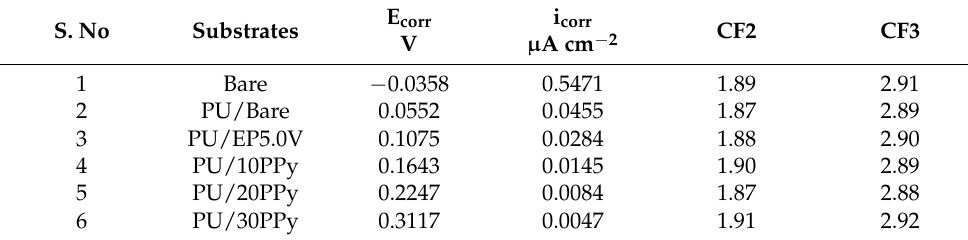
Figure 8. EFM curves of prepared coatings on passivated and bare specimens in a 3.5% NaCl solution. Table 3. EFM parameters of uncoated and coated 316L SS specimens in a 3.5% NaCl solution.